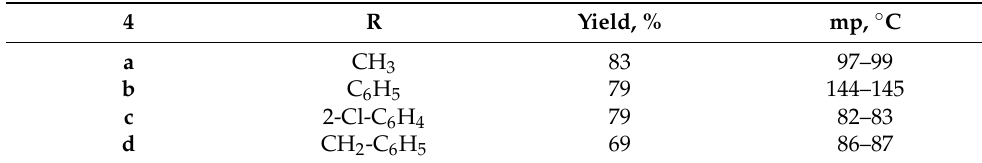
Table 1. Synthesis of 3-methyl-1-phenylbutan-2-amine.